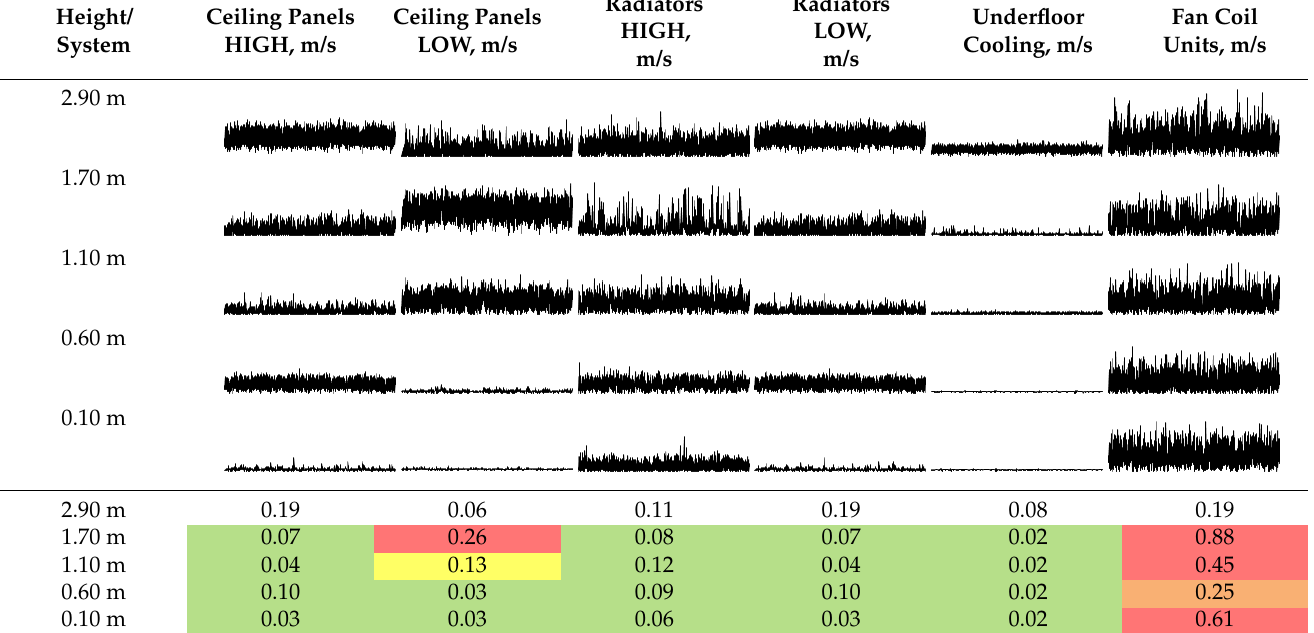
Table 6. Air velocities as measured on the tripod. Cat. I in green, Cat. II in yellow, Cat. III in orange, and the exceeding thermal comfort class boundaries are in red.